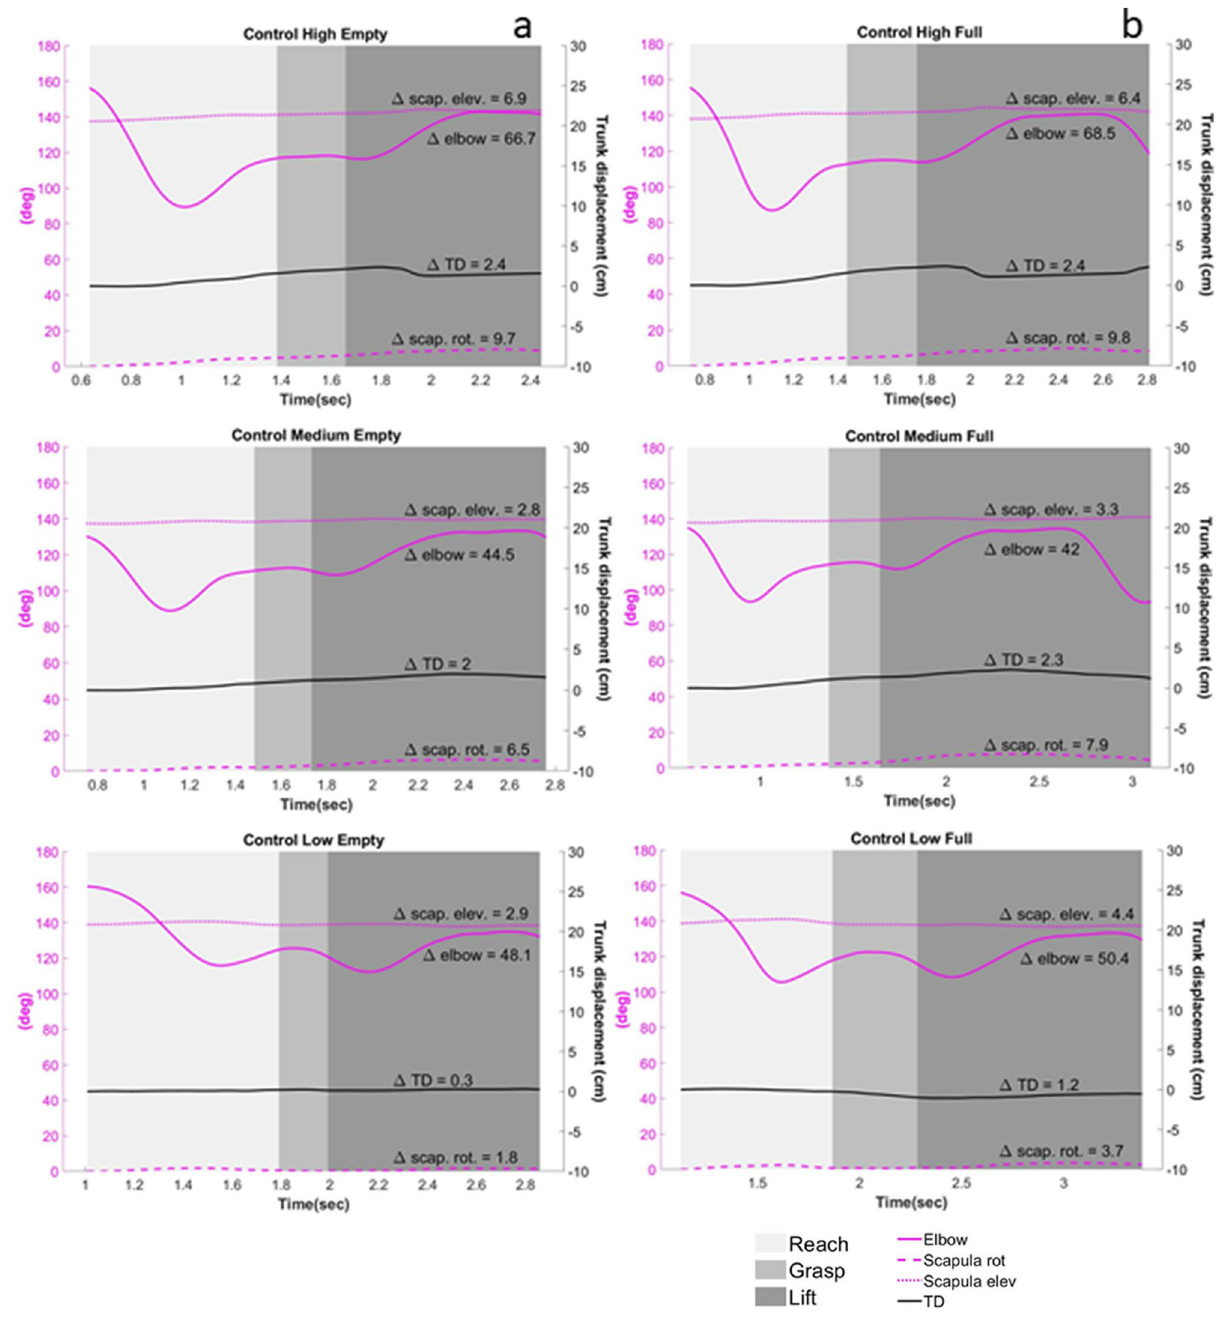
Figure 4. Graph of the RTG movement of one post-stroke participant (P29; FMA = 33; moderate-severe) and one healthy control (C01). The movement of the different joints in the three different heights and two different weights according to the three parts of the movement: Reach, Grasp, and Lift. Left axis (purple) represents movement in degrees of the scapula and elbow; right axis (black) represents TD in cm. Control’s RTG to the different heights with an empty cup [line ( a )] and a full cup [line ( b )]; Patient’s RTG to the differnt heights with an empty cup [line ( c )] and a full cup [line ( d )]. D: the difference in deg/cm form T1 to T4. As is clearly evident, the patient uses trunk displacement and scapular elevation as part of the movement, whereas the control participant hardly shows any involvement of the trun. Abbreviations: RTG: Reach to grasp; TD: Trunk displacement; scap: Scapula; cm: centimeters; deg: